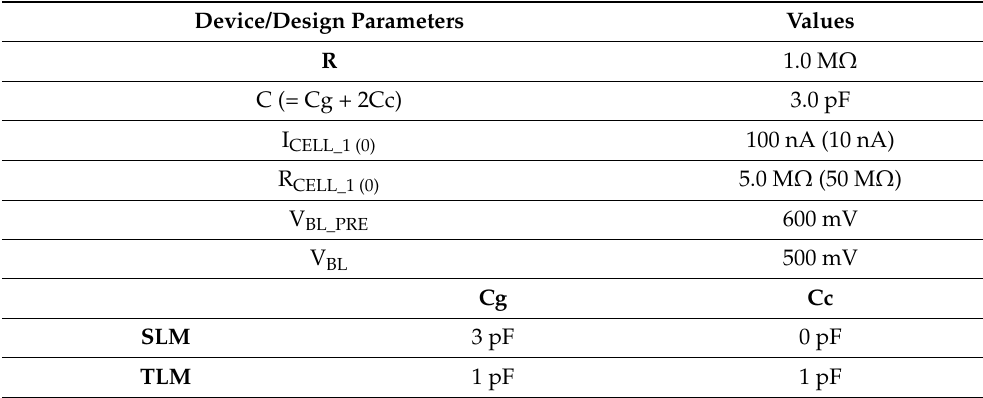
Figure 2. BL path models studied in this paper. ( a ) Single line model (SLM). ( b ) Three-line model (TLM) and ( c ) TLM with PASS transistors. The cell current model given by a liner resistor R C is omitted in ( b , c ), but each R C is connected with each BL in actual netlists for simulation. Table 1 summarizes the device and design parameters used in this study. The memory cells are modeled by linear resistors for simplicity. Distributed RC elements are used for BL operations. The selected memory cells are located at x percentages of 25%, 33%, 50%, 66%, 75%, and 100%. Table 1. Device and design parameters used in this